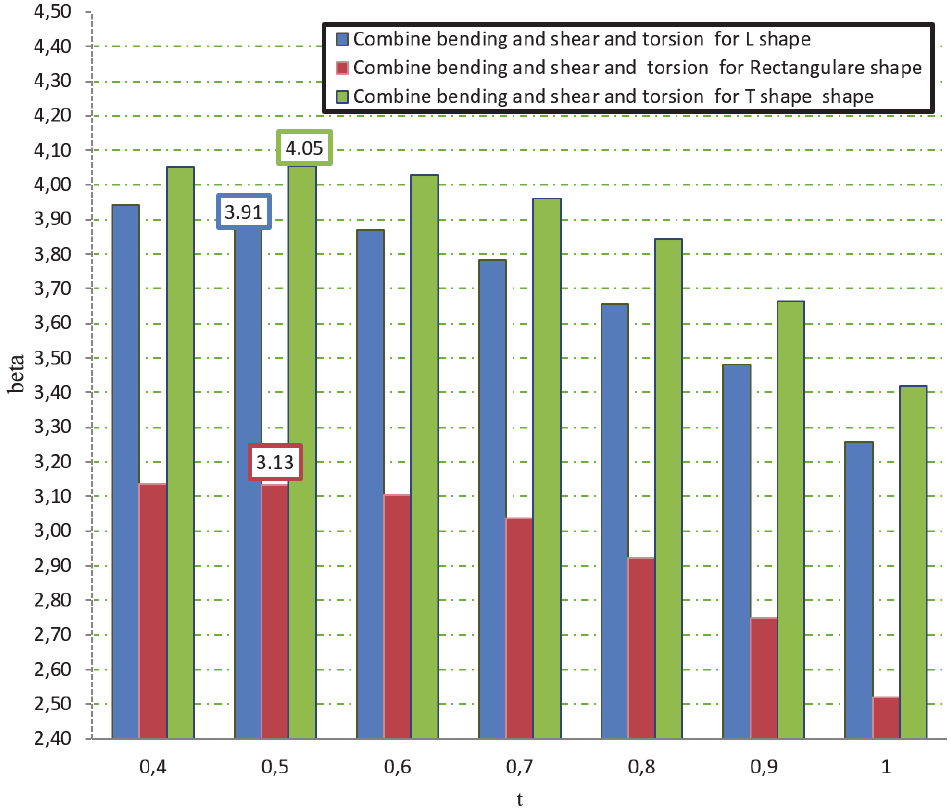
Figure 7: ACI beta index for shear-bending -torsion